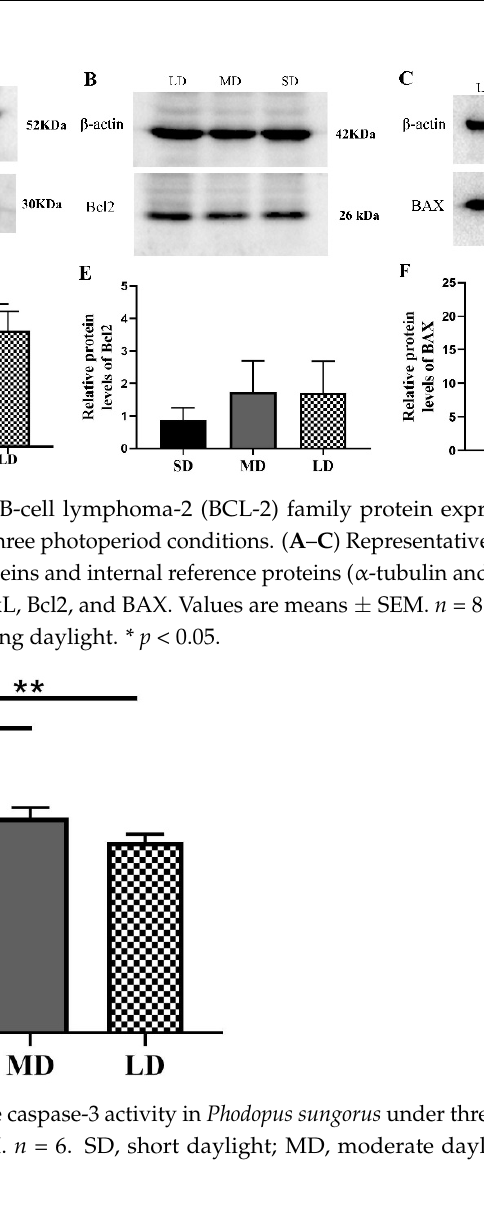
Figure 9. Levels of the PI3K/Akt signal pathway protein expression in the ovaries of Phodopus sungo- rus under three photoperiod conditions. ( A , E , F ) Representative immunoblots of the key P-Akt, Akt, HtrA2, and DIABLO proteins and internal reference proteins ( β -actin and α -tubulin). ( B , C , G , H ) Relative protein expression of P-Akt, Akt, HtrA2, and DIABLO. ( D ) Ratio of P-Akt to Akt. Values are means ± SEM. n = 8. SD, short daylight; MD, moderate daylight; LD, long daylight. * p < 0.05.